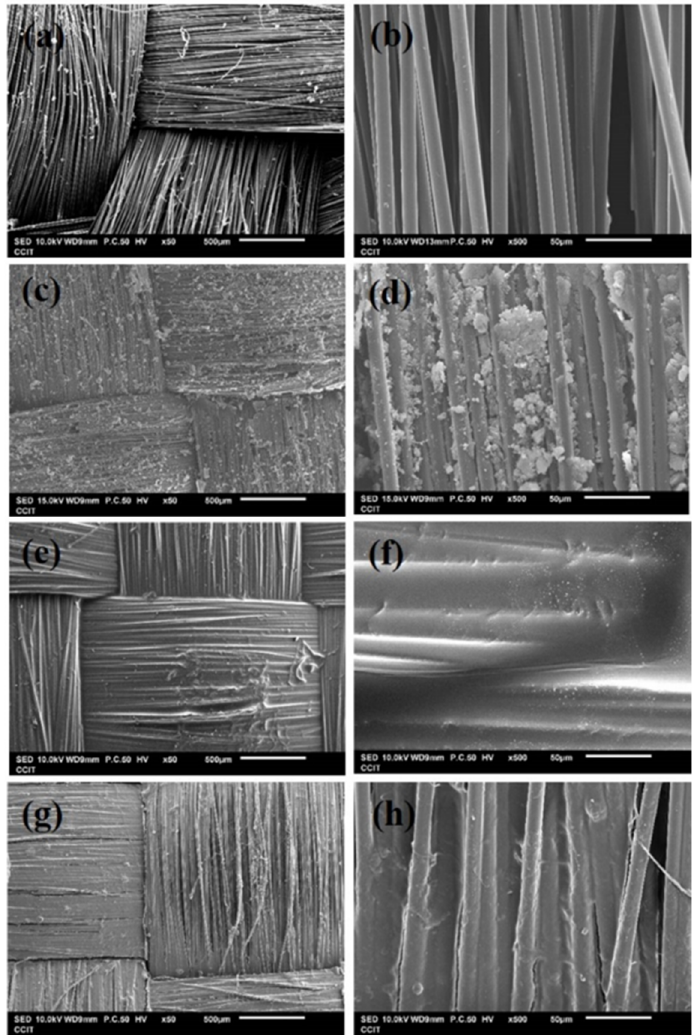
Figure 2. SEM images of the ( a , b ) Neat Kevlar plates; ( c , d ) STF/Kevlar plates; ( e , f ) Epoxy/Kevlar plates; ( g , h ) Polyurea Elastomers/Kevlar